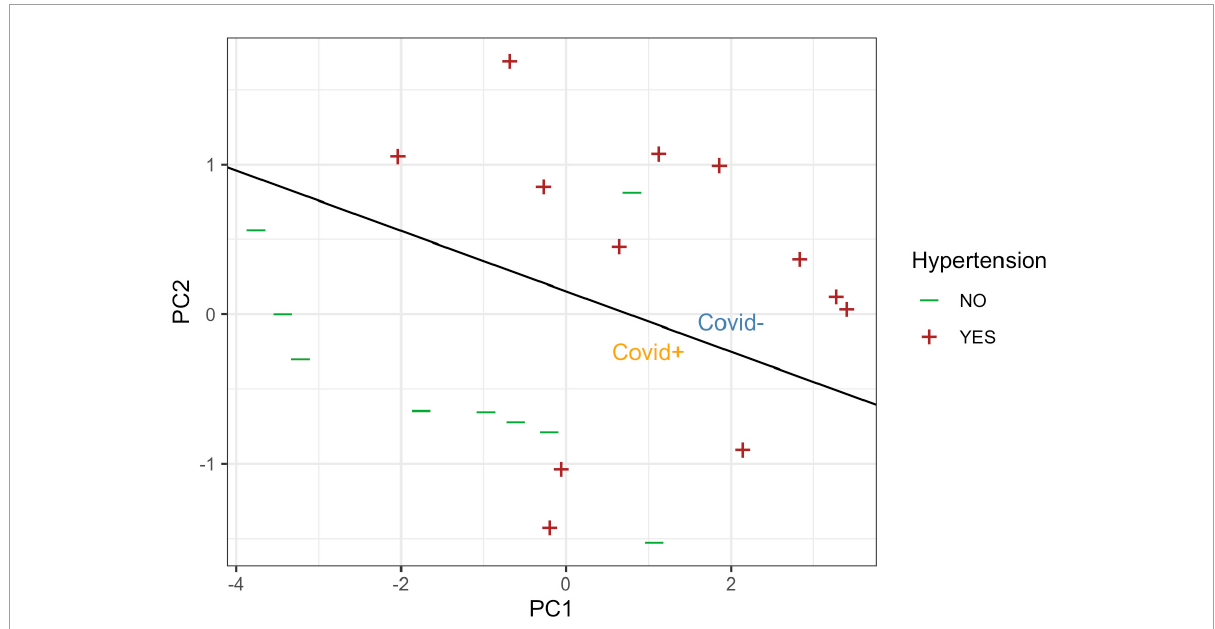
FIGURE2 Presence of hypertension, plotted against the first two principal components of the four serum markers (log-CRP, D-DIMER, PT, and INR). The black line denotes the linear class boundary separating the SARS-CoV2/COVID-positive (orange, below) and SARS-CoV2/COVID-negative cases (blue area above the